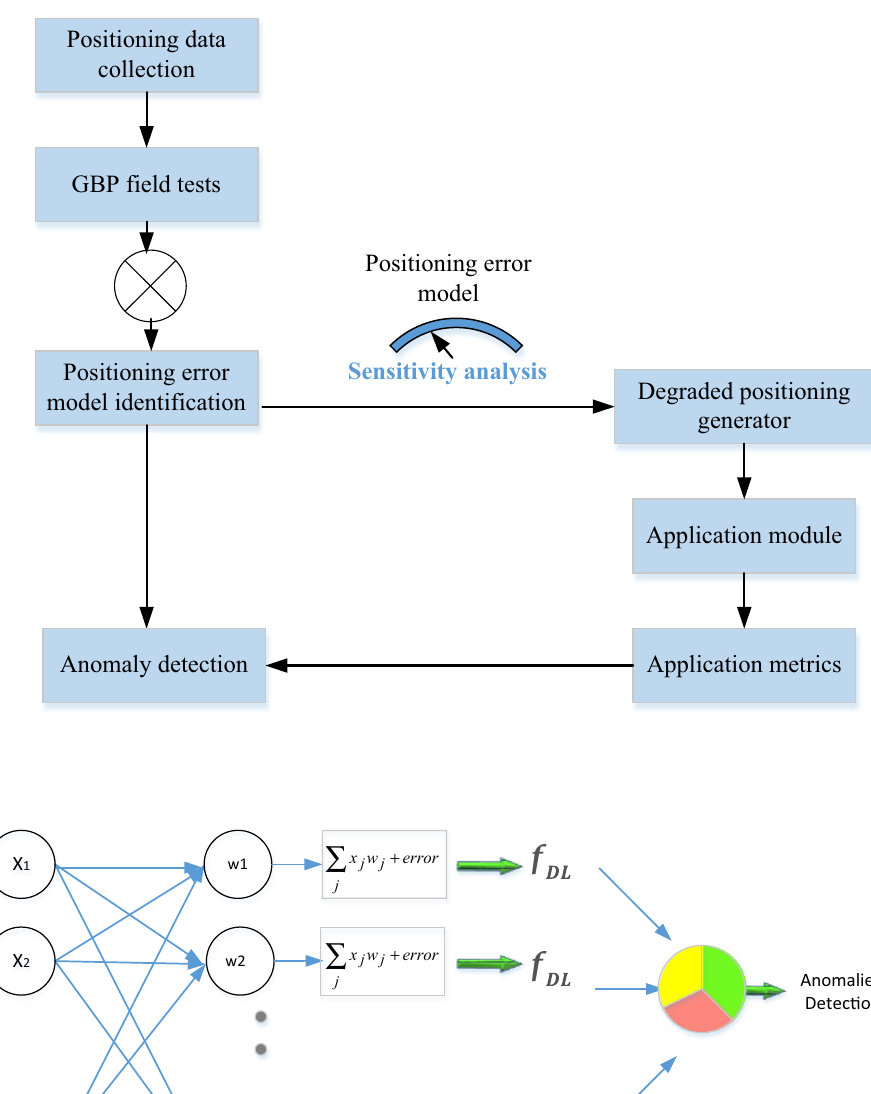
Fig. 9 Positioning error iden- tification